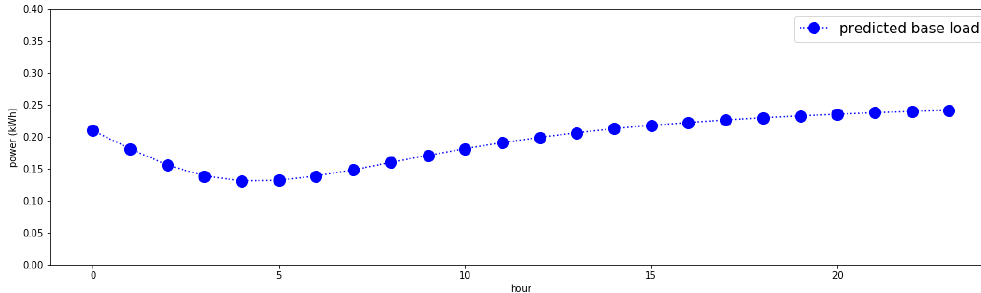
Table 2. Base load prediction model.